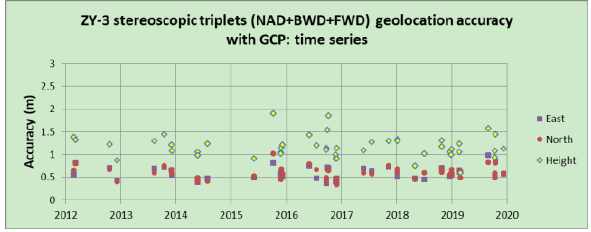
Figure 14. ZY-3 stereoscopic triplets (NAD+BWD+FWD) geolocation accuracy with GCP